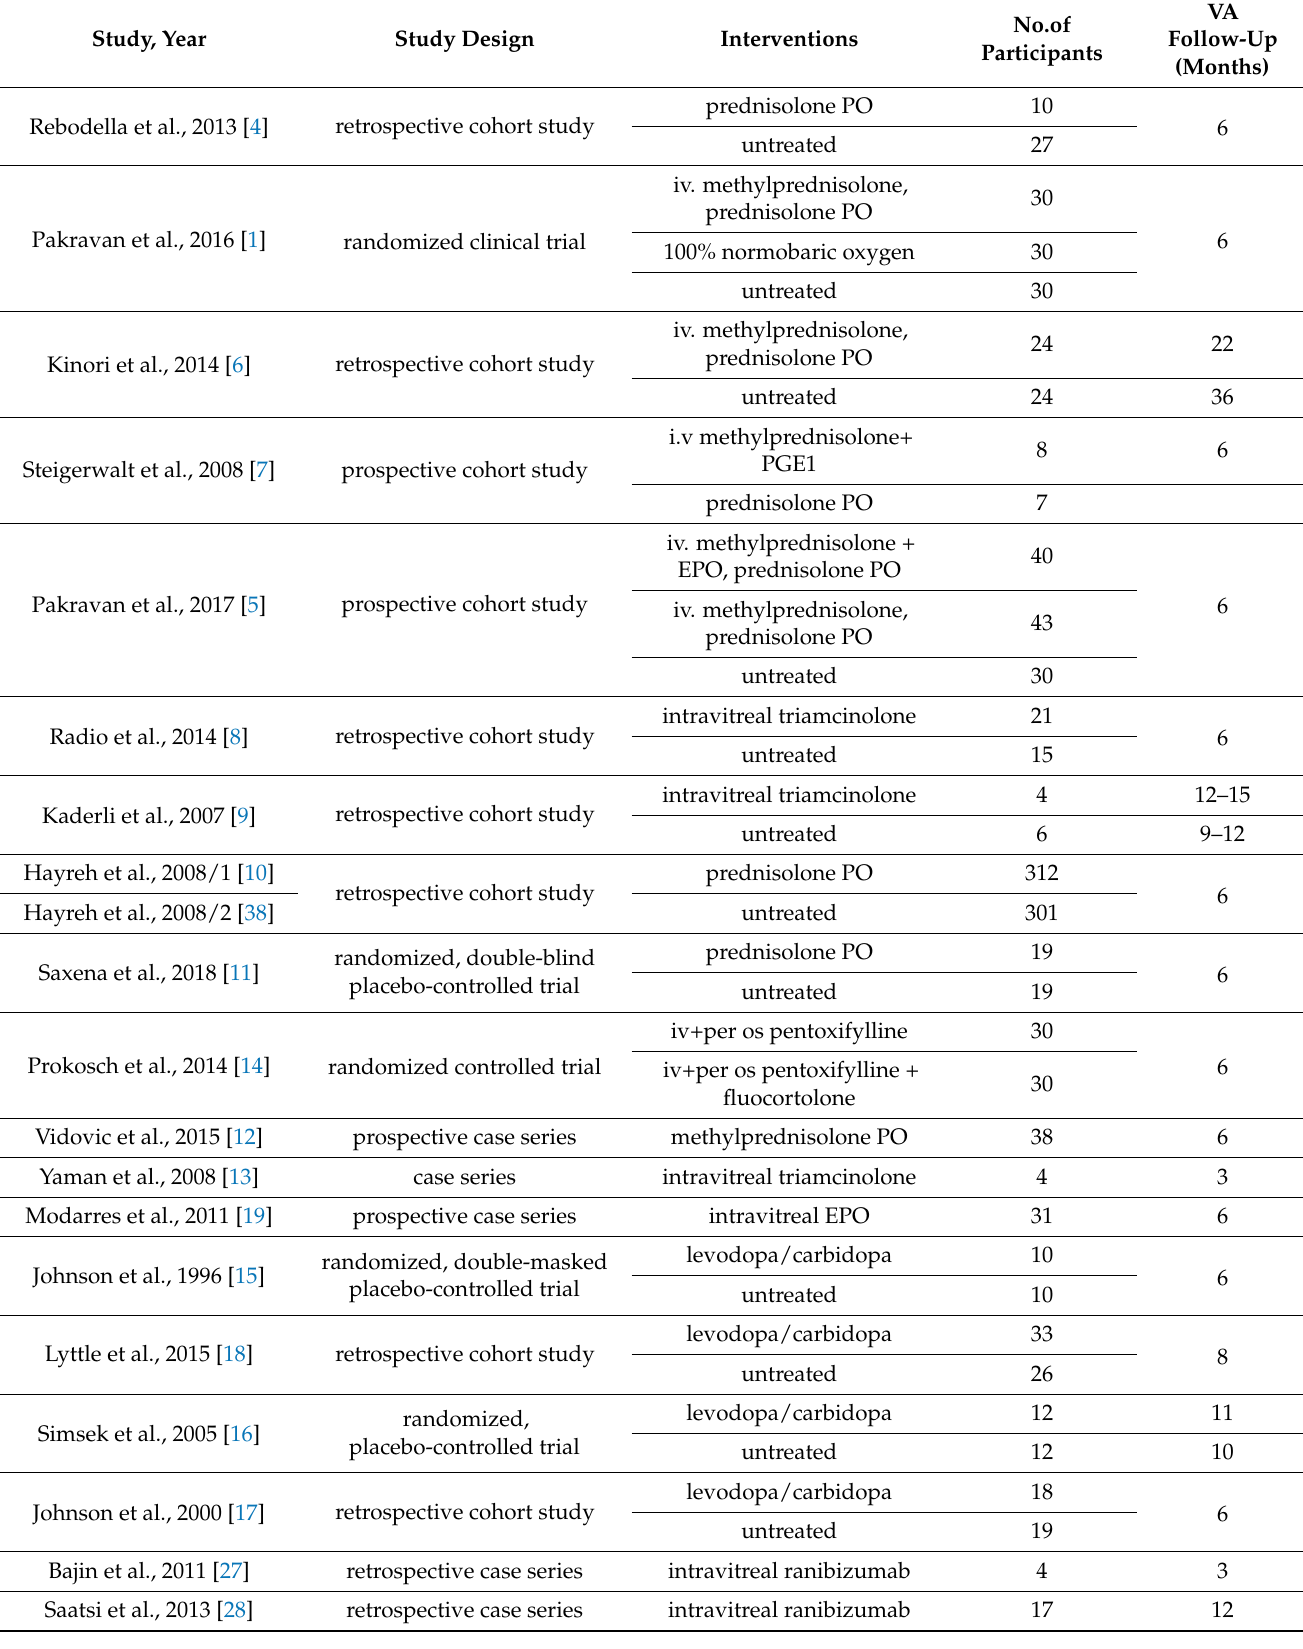
Table 1. Characteristics of the studies